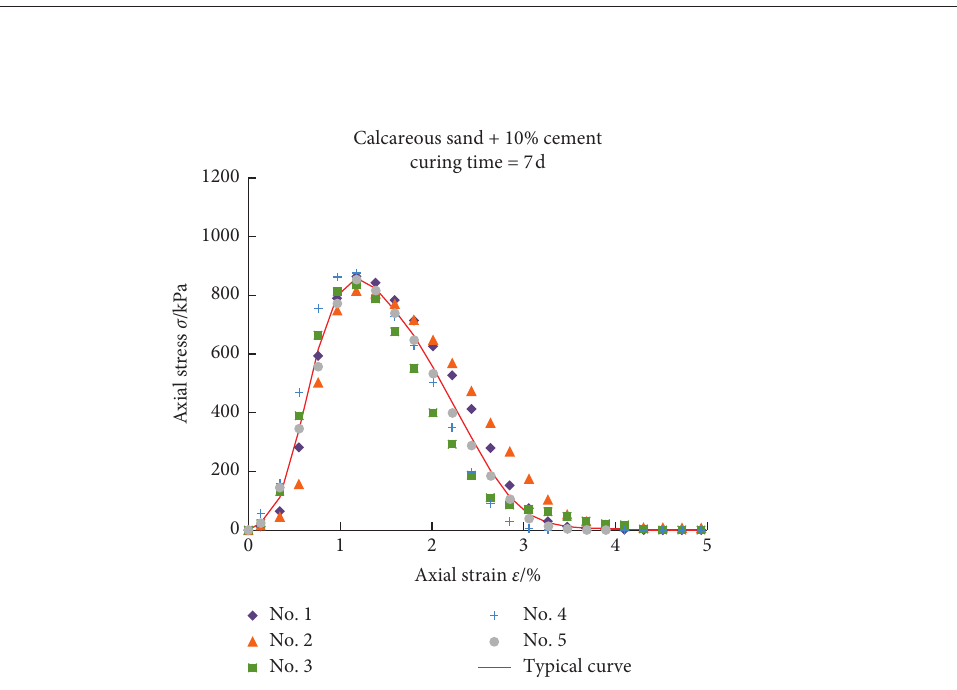
Figure 8: The stress-strain curves after CCS